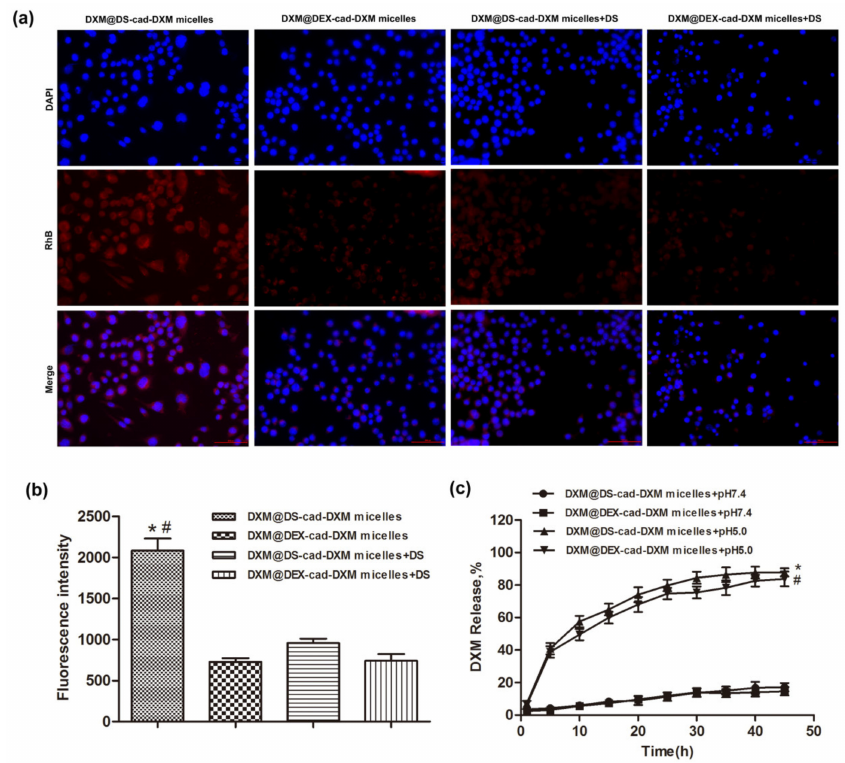
Figure 4. Fluorescent images of the DXM@DS-cad-DXM micelles and DXM@DEX-cad-DXM micelles uptake by the LPS-activated RAW264.7 cells for 2 h incubation. To saturate the scavenger receptor (SR), the RAW264.7 cells were pretreated with free DS for 2 h. Scale bar = 50 µ m ( a ). Quantitative analysis of the fluorescence intensity from the fluorescence images ( b ). pH-dependent release